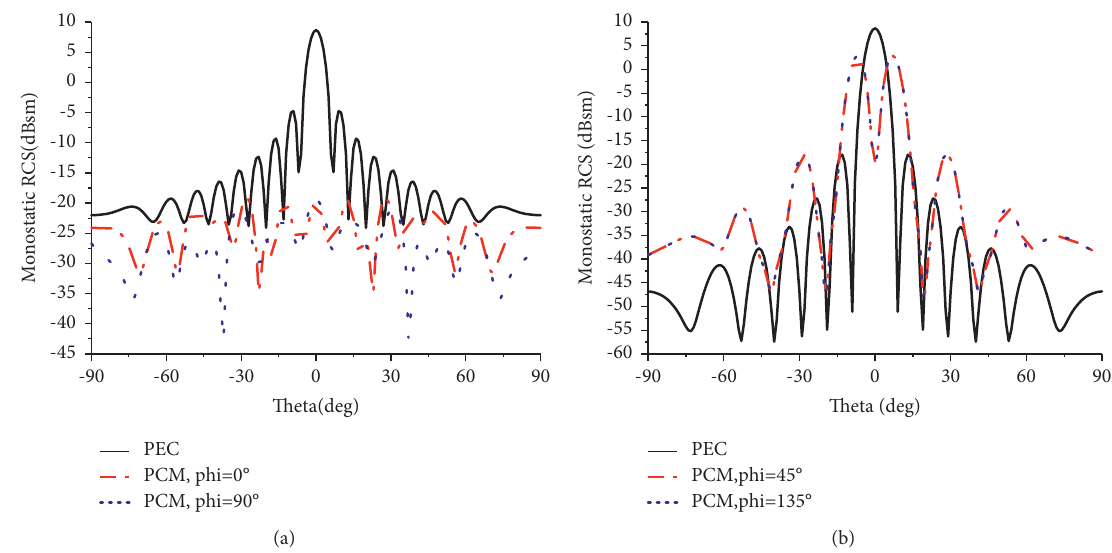
Figure 7: Comparison of RCS pattern of PCM and PEC at 82GHz. (a) phi � 0 ° and 90 ° . (b) phi � 45 ° and 135 ° .